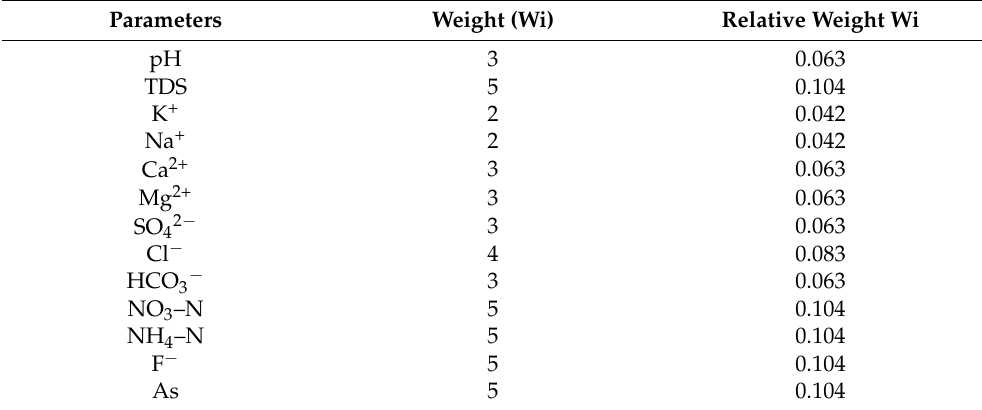
Table 2. Entropy weights for the parameters.